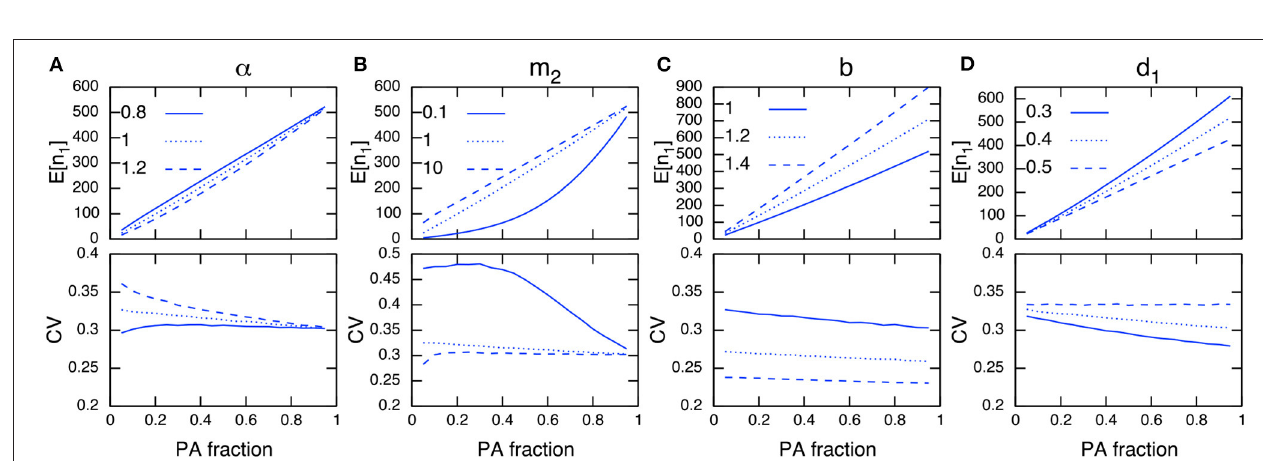
FIGURE 5 | Parameter dependence on E[ n 1 ] (top) and CV in PAs (bottom) under environmental stochasticity. The parameters being examined are α (A) , m 2 (B) , b (C) , and d 1 (D) . Other parameter values used (unless specified) are b = 1, d = 0.001, d 1 = 0.4, d 2 = 0.5, m 1 = 1, m 2 = 1, α = 1 and σ 2 e = 0.1. Note the site preference is α < 1 when PAs are preferred and α > 1 when non-PAs are preferred.